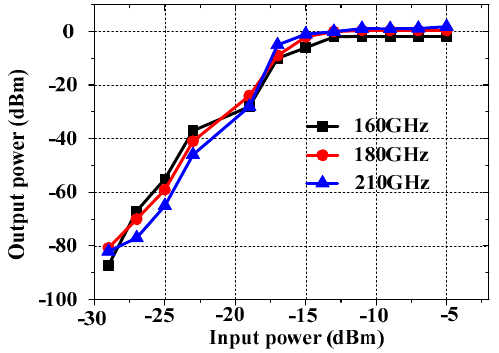
Figure 16. The maximum gain with buffer is 16 dB with a − 15 dBm input at 210 GHz. The phase noise is also measured, and it is increased by 20 dB at 230 GHz with a 1-MHz frequency offset after calibration. At 1.6 V, the presented circuit achieves an efficiency of 3.7% (including all buffers) at 210 GHz. Figure 17 shows the phase noise measurement results for different frequencies.